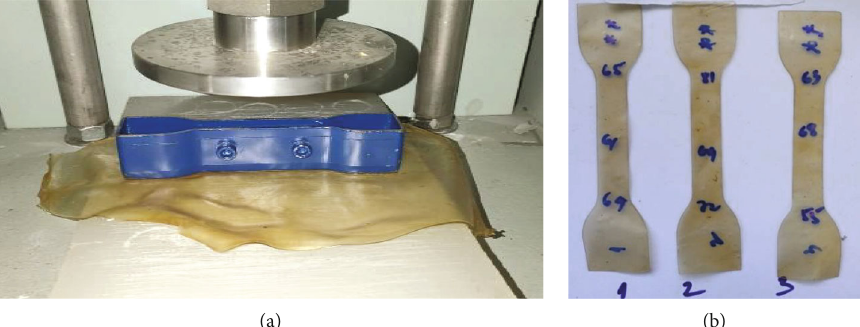
Figure 4: Characterization for mechanical properties. (a) Stamping process for dog-bone samples. (b) Dog-bone samples for tensile